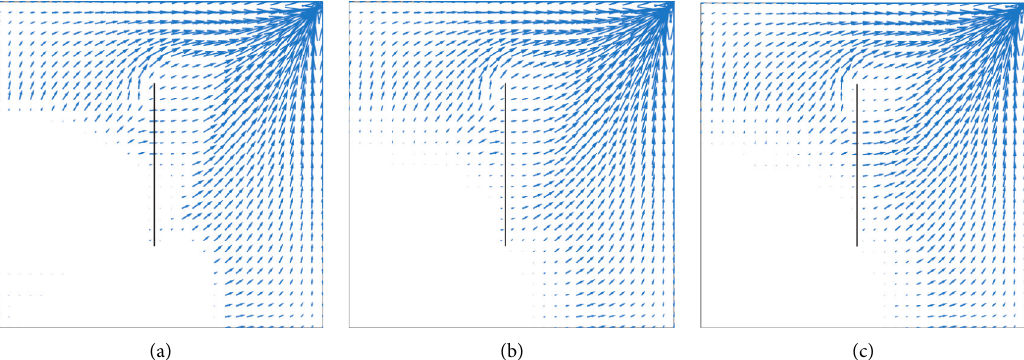
Figure 15: Oil phase flow fields for (a) upscaled fine grid simulation, (b) pIEDFM, and (c) EDFM after 1800seconds of injection.